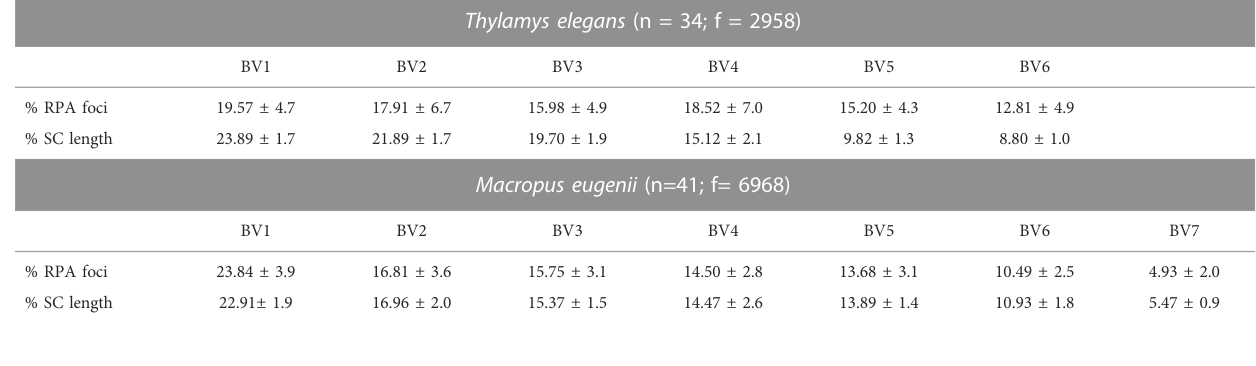
TABLE 2 Proportion of RPA foci and SC length of each bivalent at early pachytene, calculated over the number of foci and SC length of autosomes. Only cells in which all bivalents could be recorded have been included. Values are presented as mean ± standard deviation. n: number of cells analyzed; f = number of foci.